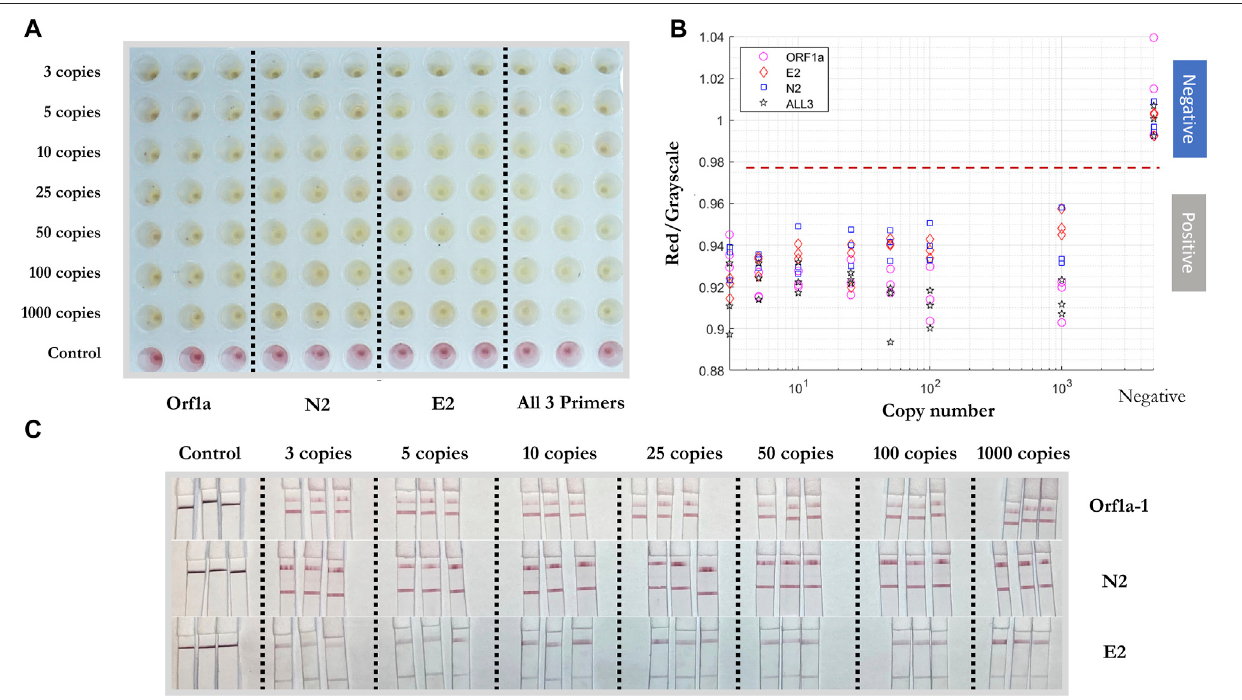
FIGURE 5 | Sensitivity test of colorimetric RT-LAMP reaction and LFIA of arti fi cial SARS-CoV-2 RNA template. (A) Positive/negative RT-LAMP products with ORF1a-1, N-2,E-2, and all three primer sets after the reaction, taken byoverview camera. (B) Red/grayscale valuevs. RNAcopy numbers ofboth positiveand negative samples. (C) LFIA read-outs for RT-LAMP products ampli fi ed for ORF1ab, N, and E gene